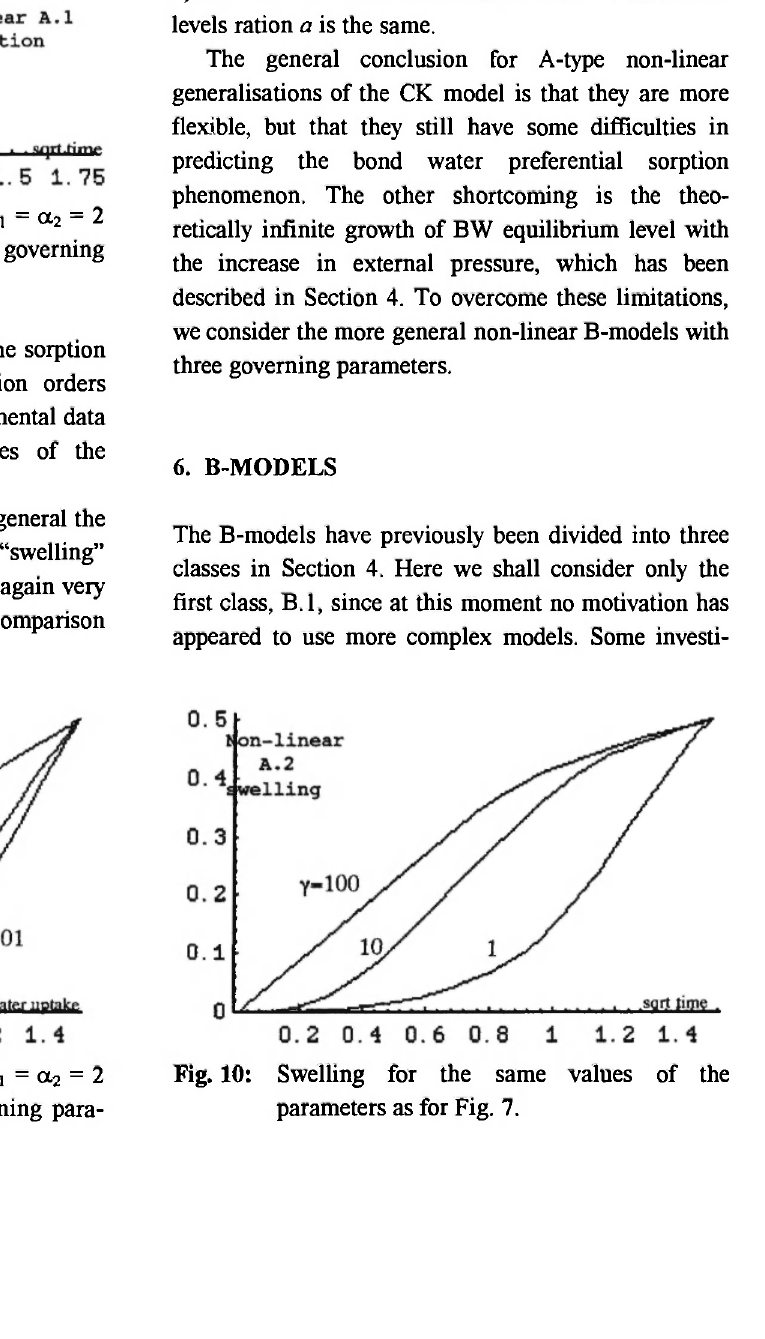
Swelling for the same values of the parameters as for Fig.